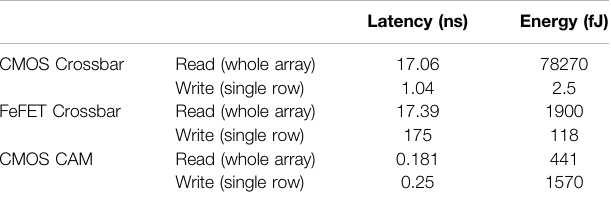
TABLE 2 | Latency and energy array-level results for CMOS and FeFET crossbars and